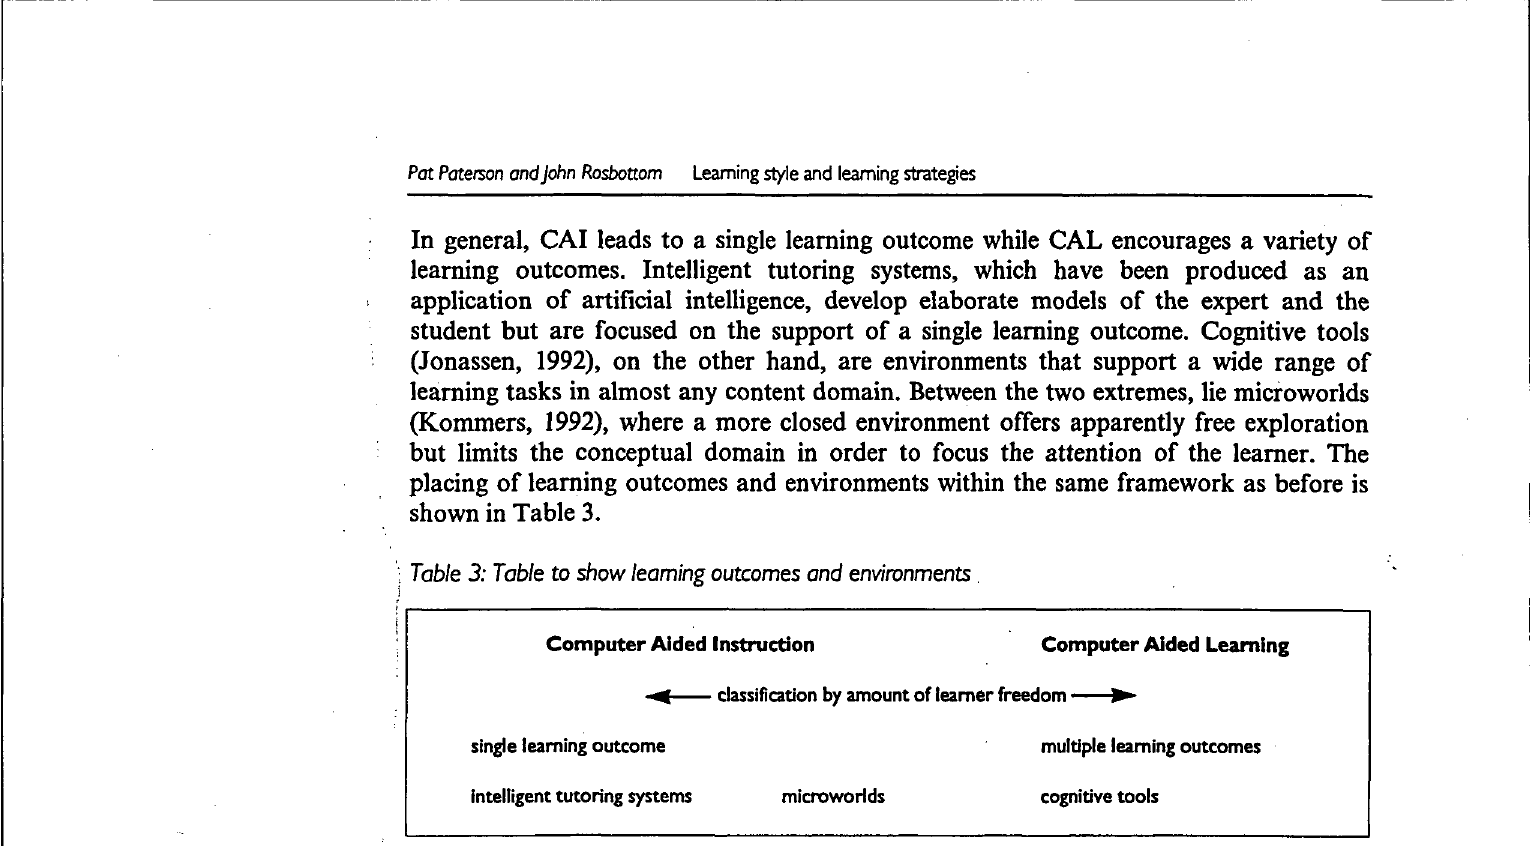
Table 4: Table to show placing of some commercial ¡MM